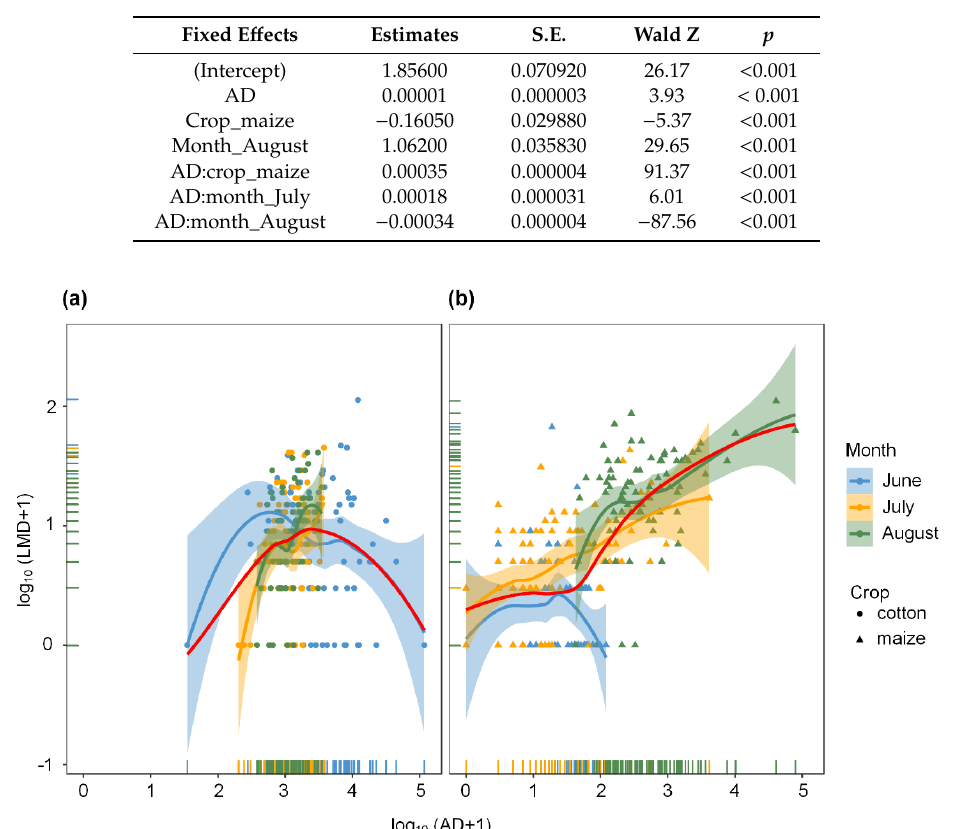
Figure 4. The relationship between aphid density (AD) and ladybeetle metapopulation density (LMD) in different sampling periods (months) on cotton and maize crops at the regional landscape scale in 2013. The data are transformed by log 10 (x + 1) before using GLMM analysis with Poisson distribution (“lme4” package of the R software). The scatter plot with different colors shows the data points (with marginal rug) and the regression trend lines (smooth curves) and 95% confidence interval band (shaded areas) in different months (June: steel blue color; July: orange color; August: pale green color). The smooth regression curve in red indicates the trend across the entire sampling period (from June to August). Circle points and triangle points indicate the data from cotton ( a ) and maize ( b ), respectively. The statistical results of GLMMs are shown in Table